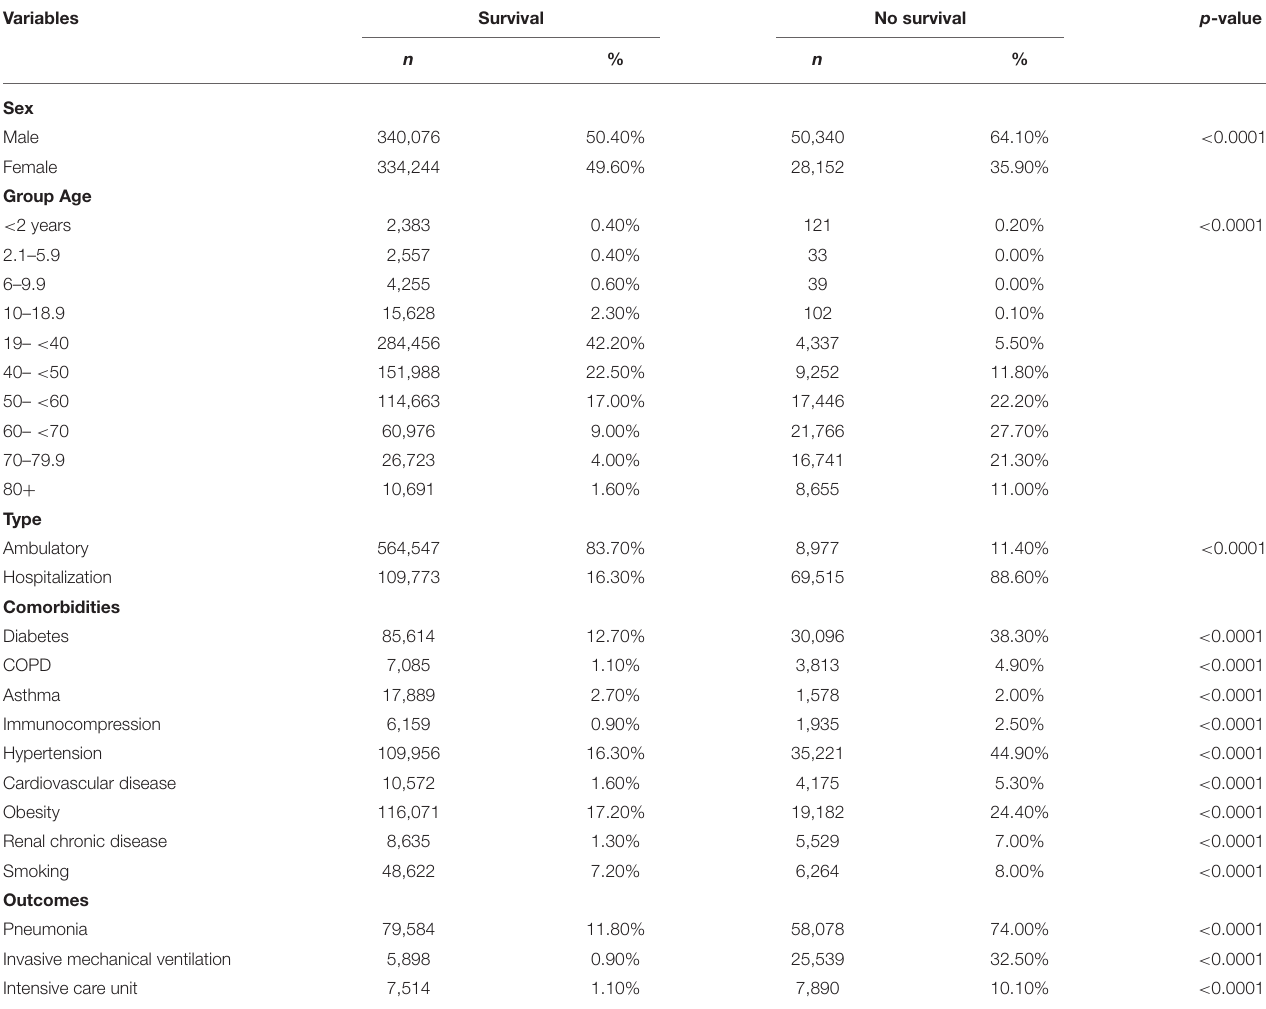
TABLE 2 | Differences between survivors and non-survivors with SARS CoV-2.